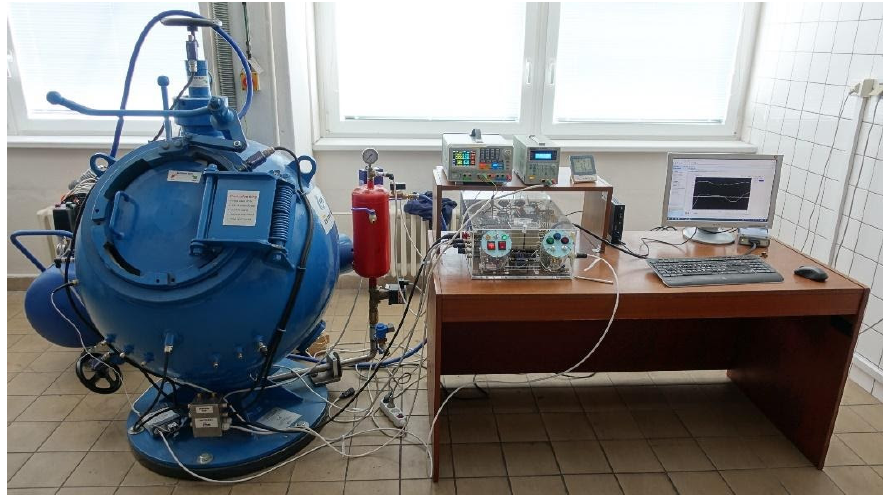
Figure 7. KV 150M2 explosion chamber.